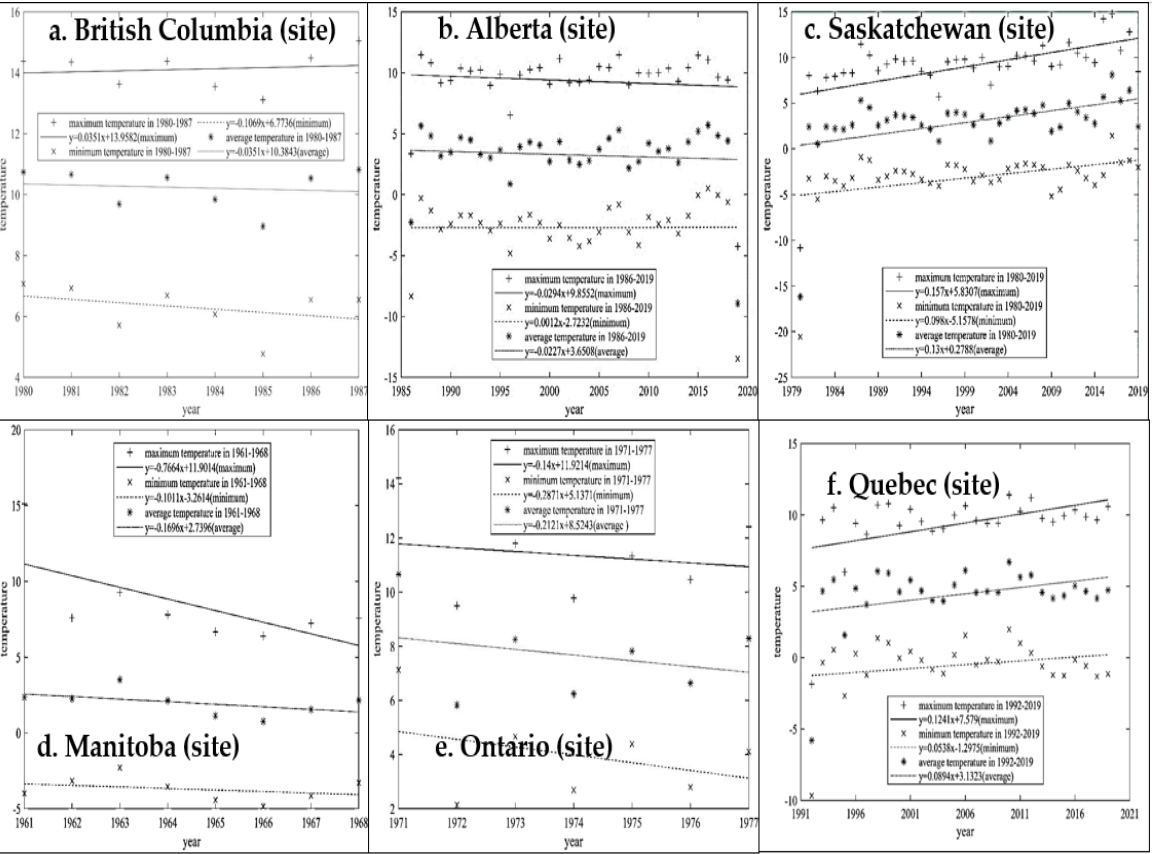
Figure 3. Scatter plot and linear fit plot. Where, ( a ). denotes British Colombia, ( b ). Alberta, ( c ). Saskatchewan, ( d ). Manitoba, ( e ). Ontario and ( f ). Quebec.